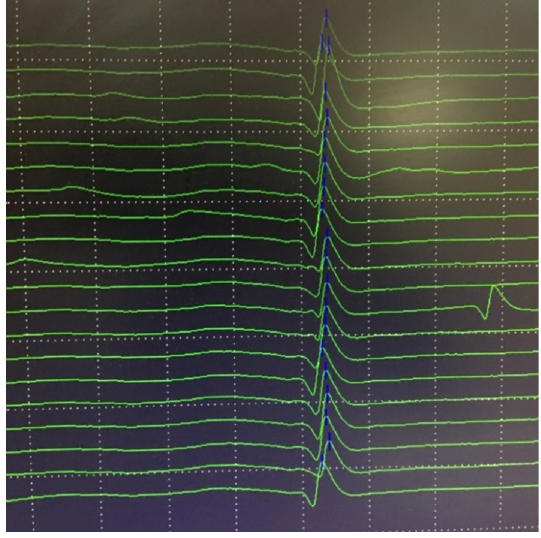
Figure 8. Normal stimulation jitter in orbicularis oculi muscle: 34 microseconds. Grid 1 mv by 0.5 msec.